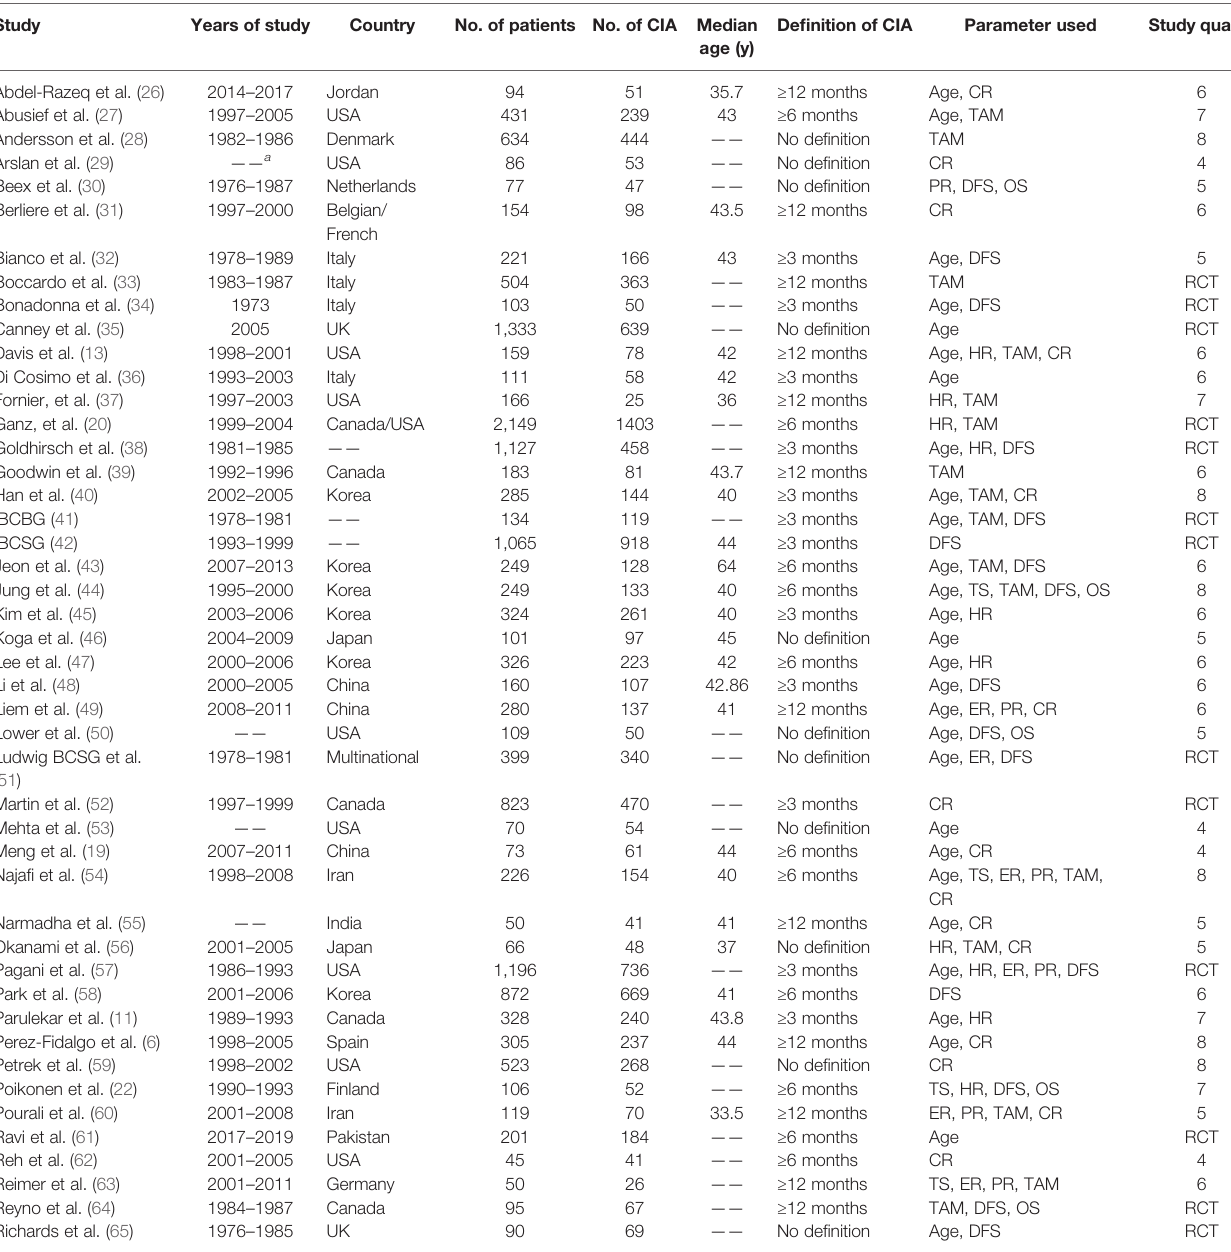
TABLE 1 | Basic characteristics of the 68 clinical trials studying patients with CIA.